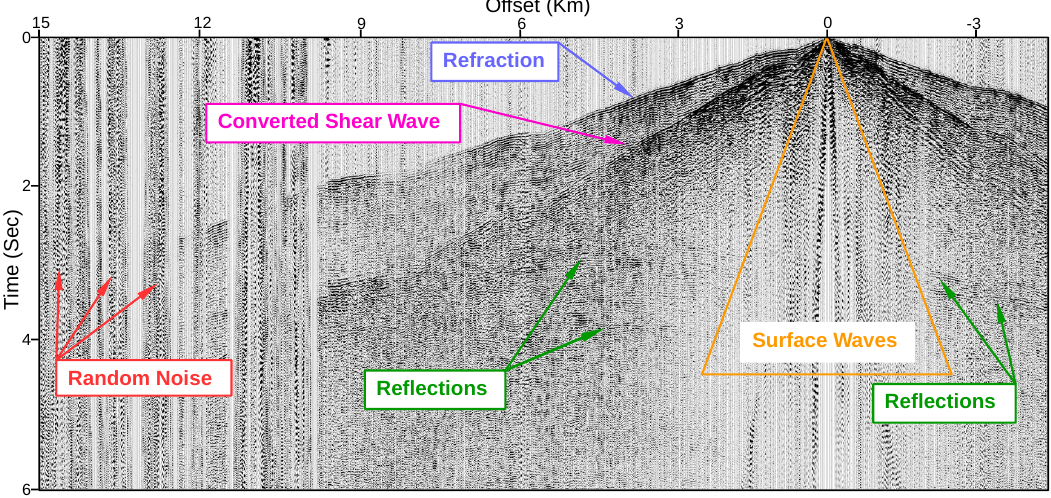
Figure 3. A shot gather from Metal Earth’s Malartic R1